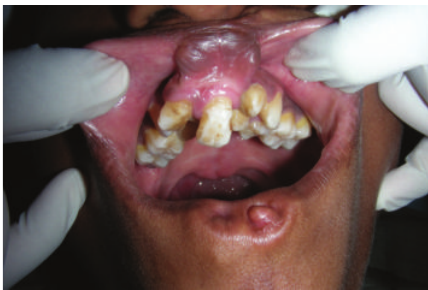
Figure 3: Crowding of teeth in upper arch along with fusion of the labial mucosa to the gingiva resulting in obliteration of labial vestibule.